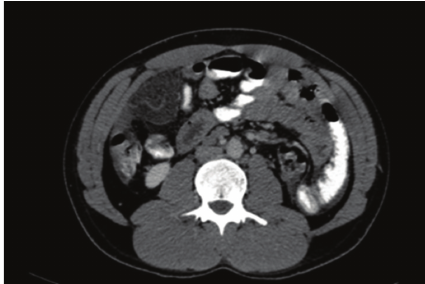
Figure 2: It shows torsion of omental masson laproscopic examina- tion.